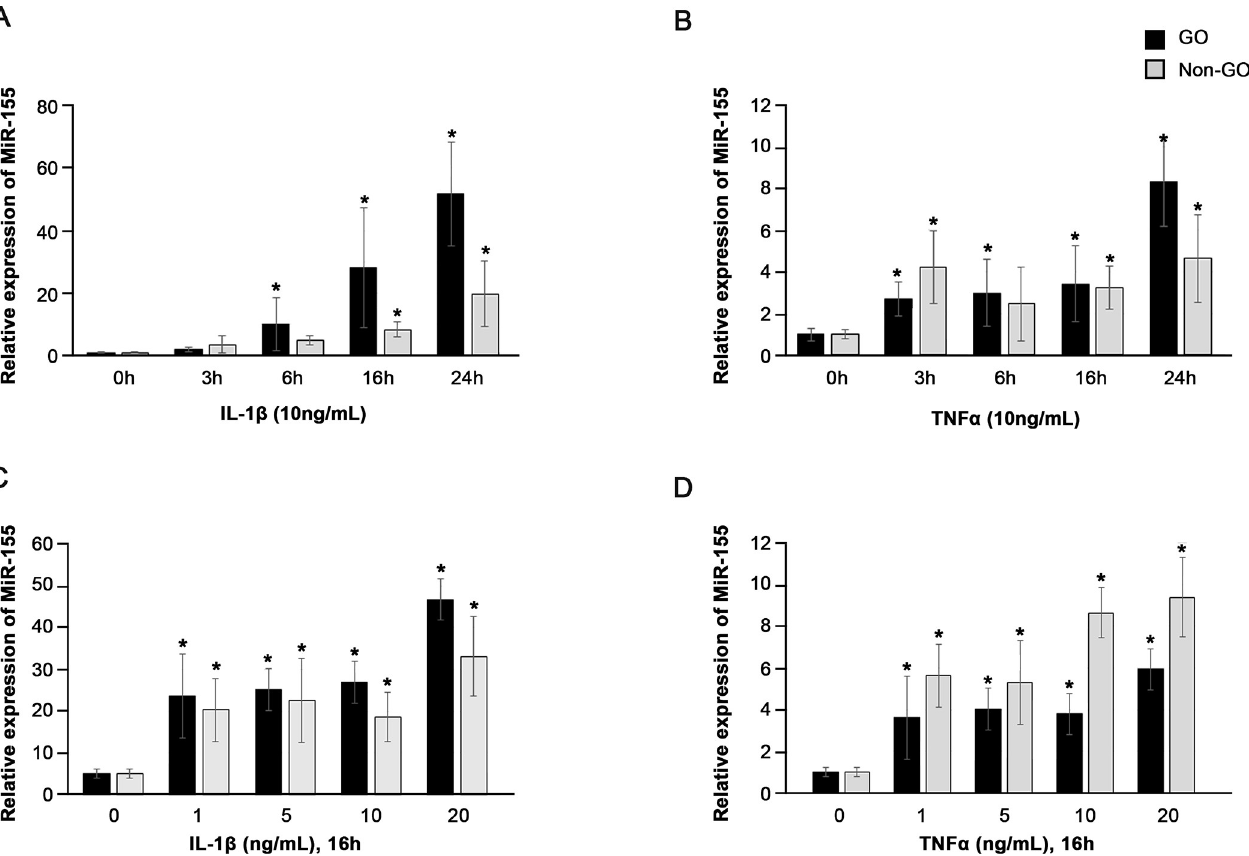
Fig 2. Effects of interleukin (IL)-1 β and tumour necrosis factor-alpha (TNF- α ) on miR-155 expression in GO (n = 5) and non-GO orbital fibroblasts (n = 5) (OFs). Note that IL-1 β and TNF- α tend to induce an increase in miR-155 expression. (A, B) Time-dependent effects of IL-1 β and TNF- α , (C, D) Dose dependent effects of IL-1 β and TNF- α . Differences between treated and untreated cells are indicated ( � P < 0.05, versus time and concentration matched controls).